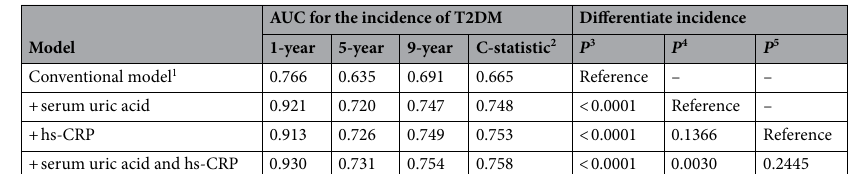
+ serum uric acid and Table 5. Overall ability of models predicting type 2 diabetes incidence in Korean adults aged 45–76 years. AUC area under the receiver operating characteristic curve; hs-CRP high-sensitivity C-reactive protein; T2DM, type 2 diabetes mellitus. 1 The conventional model is adjusted for sex (men or women), age (years), area of residence (Ansan or Ansung), education level (≤ elementary school, middle/high school, or ≥ college), smoking status (never, past, or current), alcohol consumption (g/day), regular physical activity (yes or no), body mass index (kg/m 2 ), waist circumference (cm), systolic and diastolic blood pressure (mmHg), triglyceride (mg/dL), total cholesterol (mg/dL), high-density lipoprotein cholesterol (mg/dL) and fasting blood glucose level (mg/ dL), and family history of diabetes (yes or no). 2 Uno’s C-statistic from Cox linear models. 3 Compared with C-statistic of conventional model. 4 Compared with C-statistic of + serum uric acid model. 5 Compared with C-statistic of + hs-CRP model.